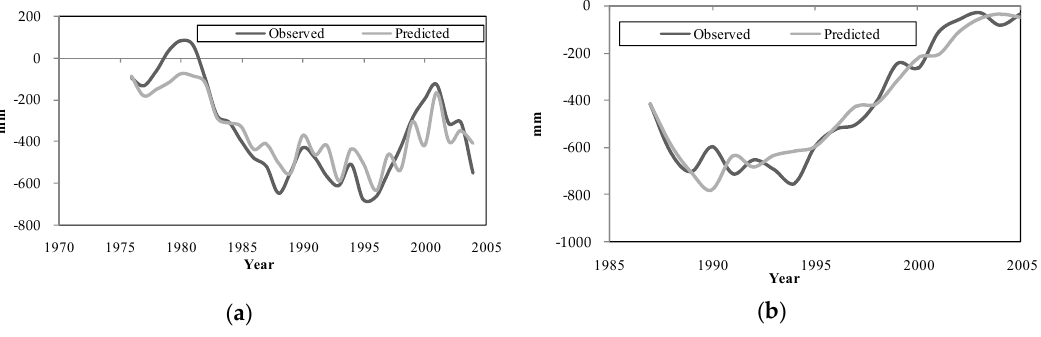
Figure 6. Observed and predicted accumulated dry season runoff variation attributed to forest change in ( a ) the Zagunao watershed and ( b ) the Meijiang watershed.